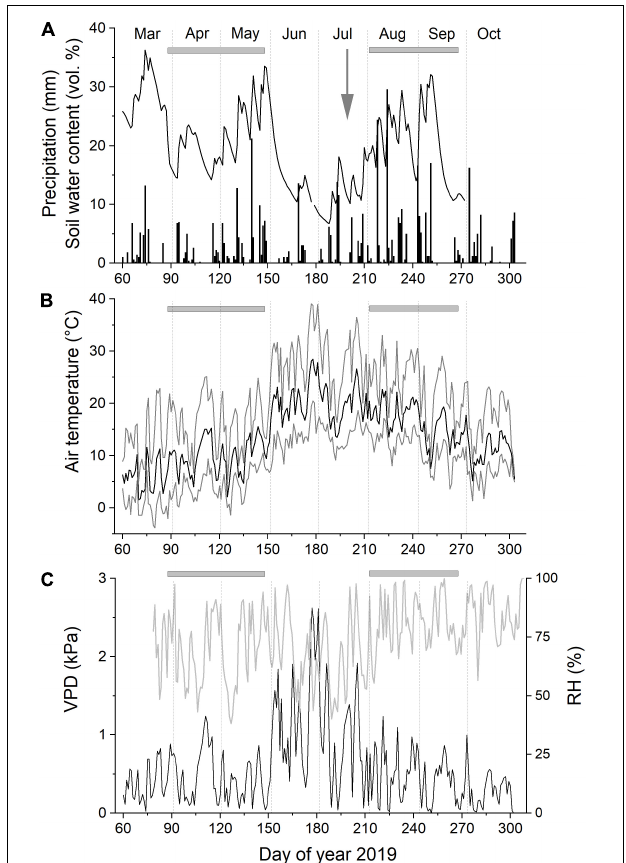
FIGURE 1 | Climate variables and soil water content recorded at the study plot from March through October 2019. Daily precipitation and soil water content (A) , mean daily air temperature (B) , and relative air humidity (RH) and vapor pressure deficit of the air (VPD; C ). Gray horizontal bars indicate regular (pre-girdling) and induced (post-girdling) growing periods in April–May and August–September, respectively (cf. Figure 2 ). Gray arrow in (A)